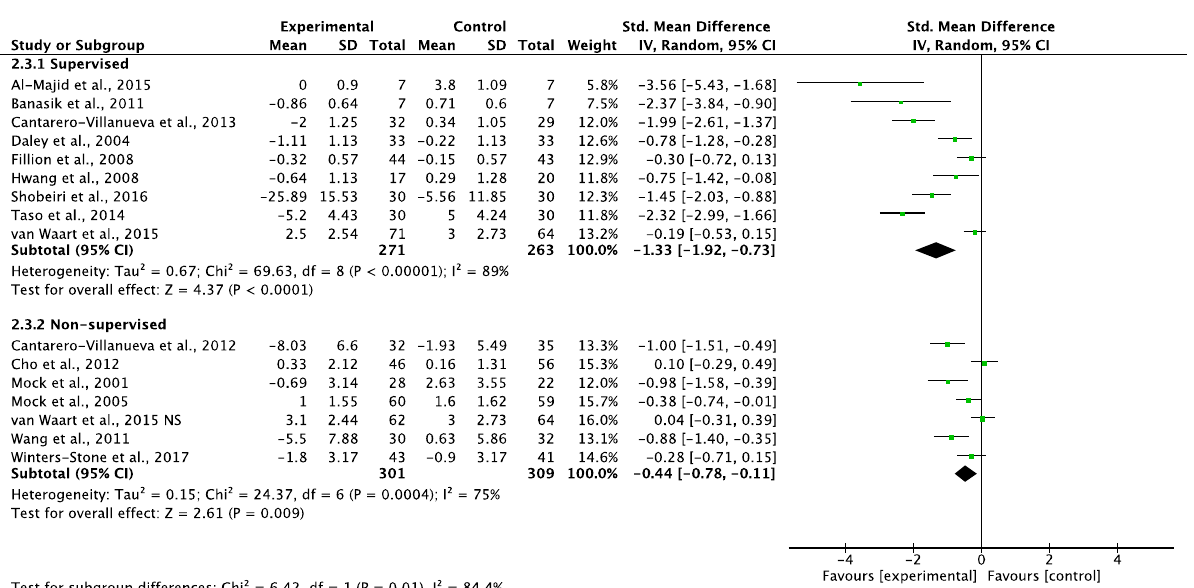
Figure 5. Meta-analyses of the effects of supervised [35,43,44,47,51,55,56,61,63] and non-supervised [36,37,39,41,45,51,54] exercise interventions of less than 12 weeks on CRF in BC patients. NS: non-supervised exercise group.